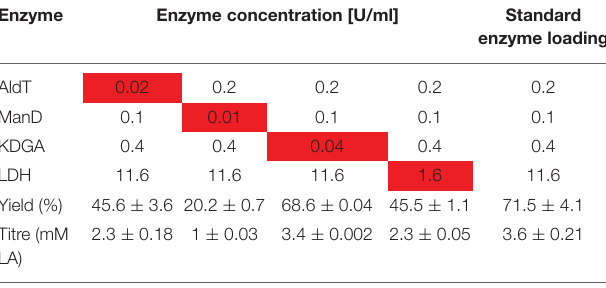
TABLE 2 | Variation of each individual enzyme loading and its effect on LA yield of the theoretical maximum. Enzyme Enzyme concentration